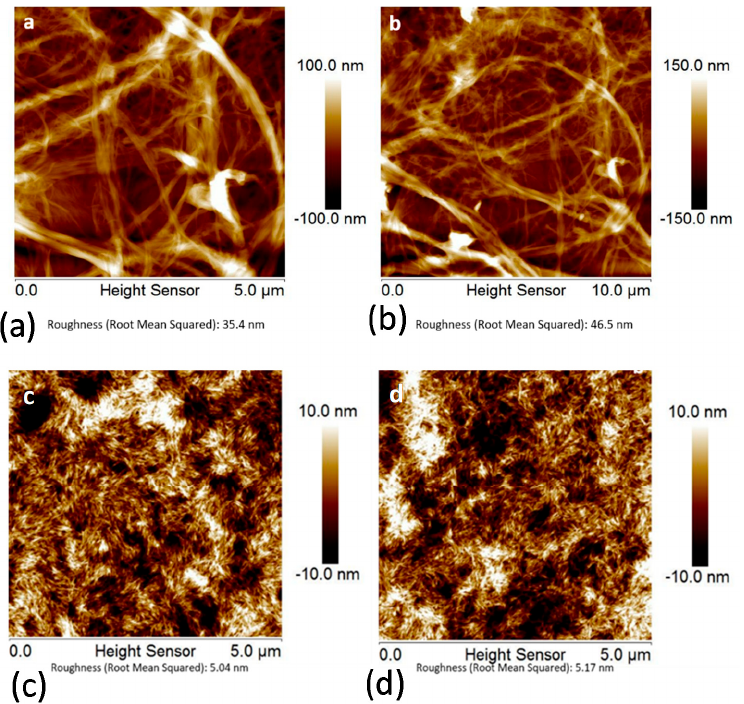
Figure 5. AFM topography images of nanocellulose coatings ( a , b ) PEI-NFC and ( c , d ) NCC + PEI on ( a , c ) PA 6,6 as-deposited and ( b , d ) after rinsing in water.